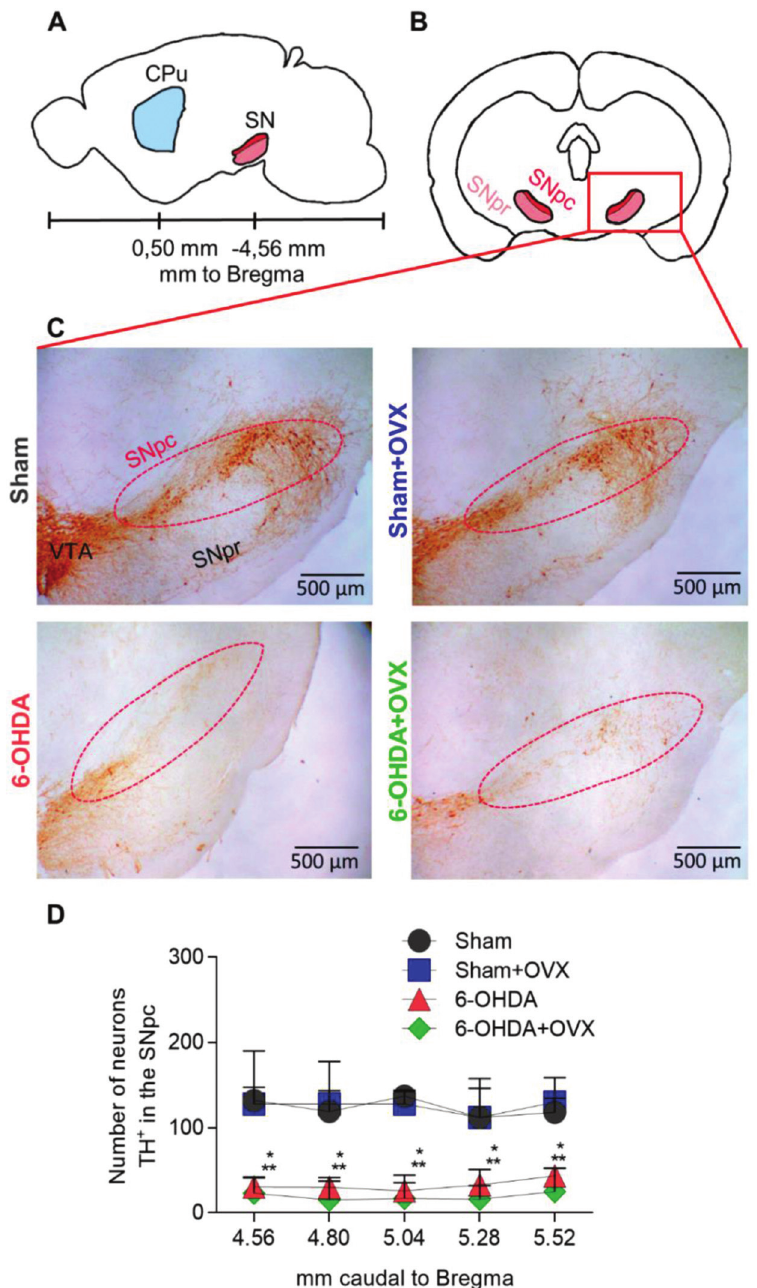
Figure 1 - Number of TH + neurons in the SNpc 40 days after striatal injection of 6-OHDA (A) Position of the CPu and SNpc in relation to the Bregma. (B) Coronal view of the SNpc and (C) photomicrographs of the SNpc neurons TH + stained. (D) The number of TH + neurons in the SNpc represented as Median ± interquartile range. Data are analyzed using the Kruskal-Wallis test and Dunn-Bonferroni post-hoc test. * p o 0.001 compared to Sham ** p o 0.001 compared to Sham + OVX. Sham, n=9; Sham + OVX, n=5; 6-OHDA, n=6; 6-OHDA + OVX, n=5. (SNpc, substantia nigra pars compacta; SNpr, substantia nigra pars reticulata; VTA, ventral tegmental area; TH, tyrosine hydroxylase; 6-OHDA, 6-hydroxydopamine; OVX,